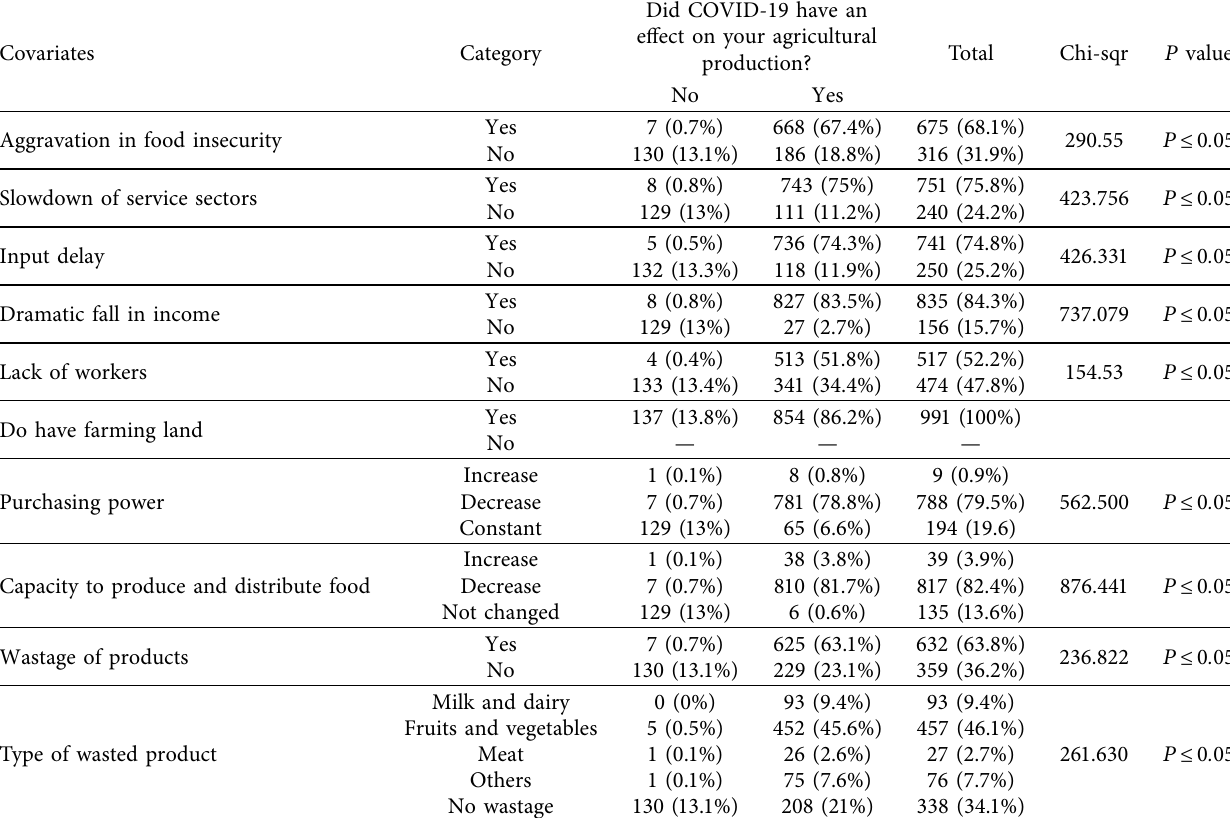
Table 3: Challenges of COVID-19 in agricultural production.